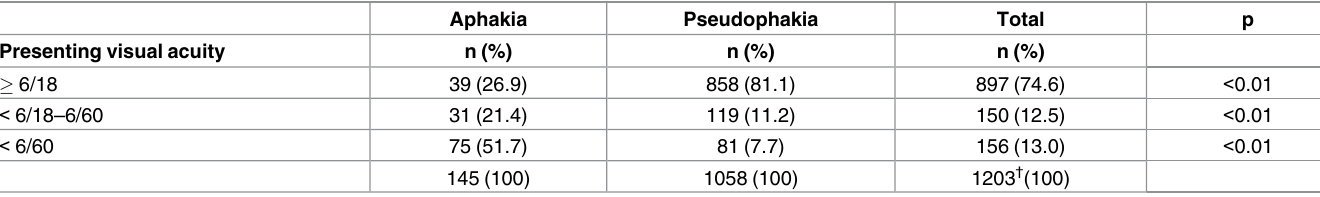
Table 3. Categories of visual impairment stratified by Aphakia and